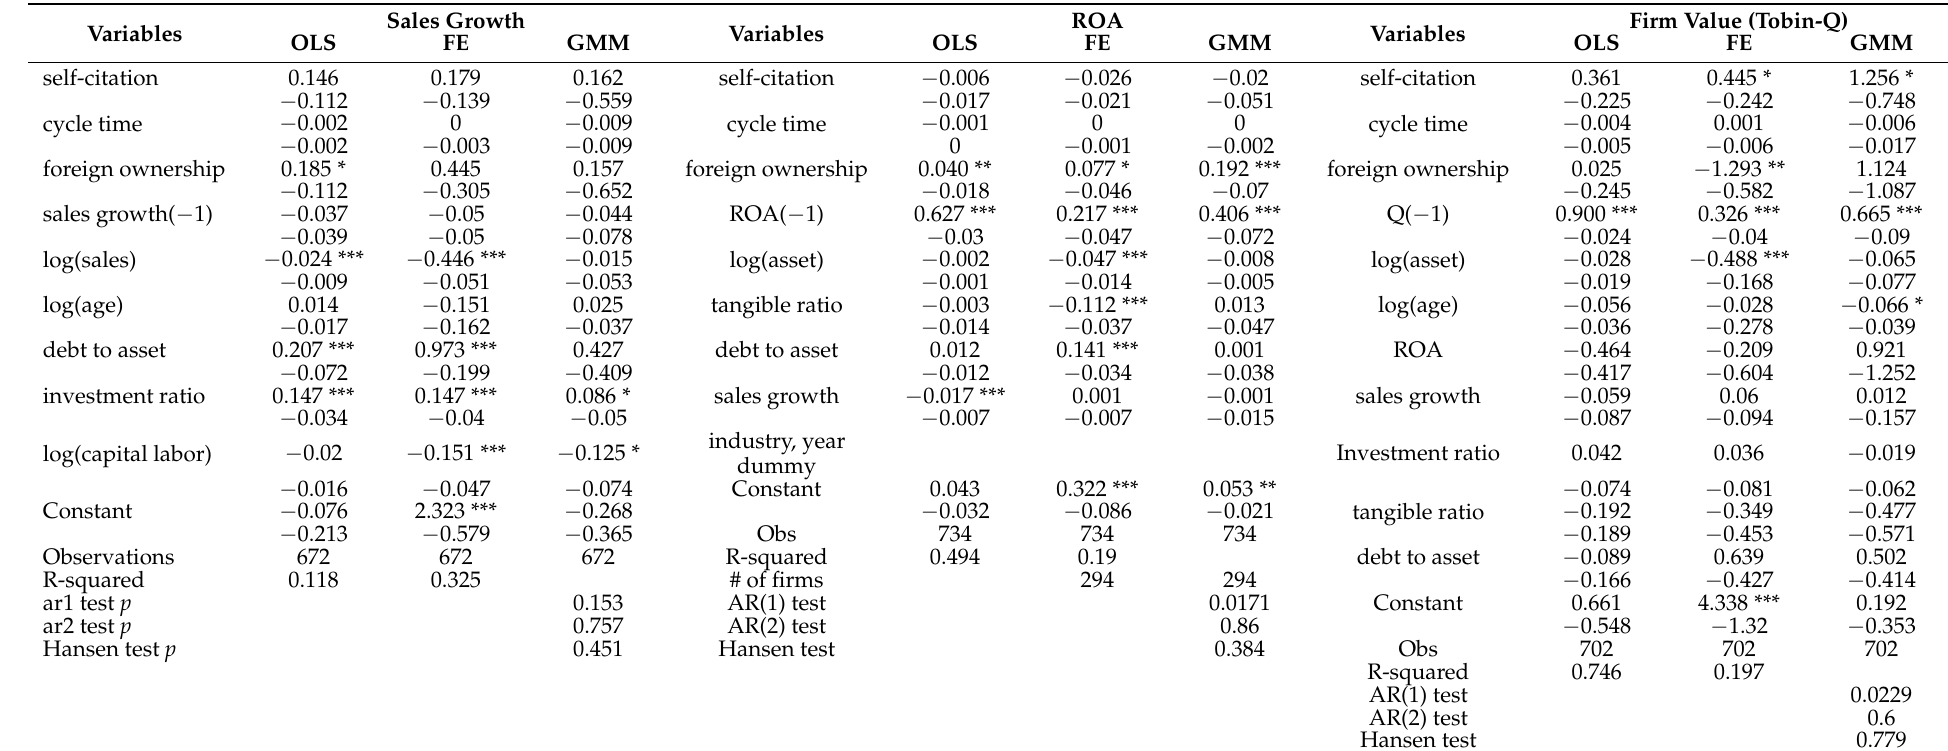
Table 11. Firm performance with the variable of foreign ownership in the 2010s: OLS, fixed effects and GMM